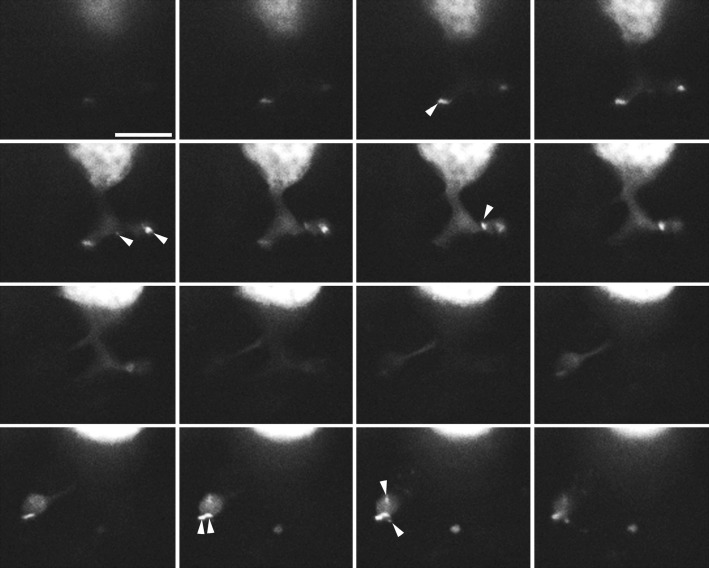
Synaptic ribbon number in rods. Sequential z-stack of images (1 μm increments) through synaptic terminals of a rod dialyzed with the HiLyte488-Ribeye-binding peptide. Ribbons extend through multiple sections and were distinguished in three dimensions. Arrowheads mark HiLyte488 puncta corresponding to each of the eight ribbons visible in this rod. Scale = 10 μm.